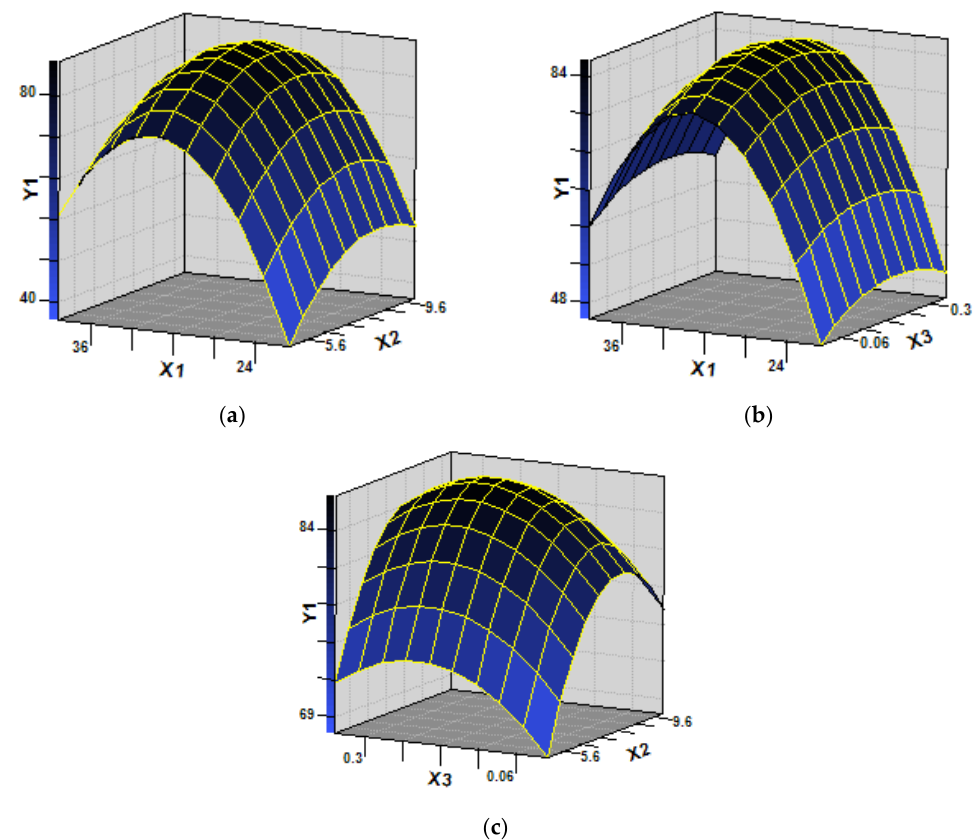
Figure 4. Response surface plots showing the interactive effects on azoxystrobin degradation by strain SH14. ( a ) effect of temperature ( X 1 ) and pH ( X 2 ) on azoxystrobin biodegradation ( Y 1 ) while fixing the value of inoculum size ( X 3 ) at a zero level (1.0×10 7 CFU·mL − 1 ); ( b ) effect of temperature ( X 1 ) and inoculum size ( X 3 ) on azoxystrobin biodegradation ( Y 1 ) while fixing the value of pH ( X 2 ) at a zero level (7.5); ( c ) effect of inoculum size ( X 3 ) and pH ( X 2 ) on azoxystrobin biodegradation ( Y 1 ) while fixing the value of temperature ( X 1 ) at a zero level (30°C).